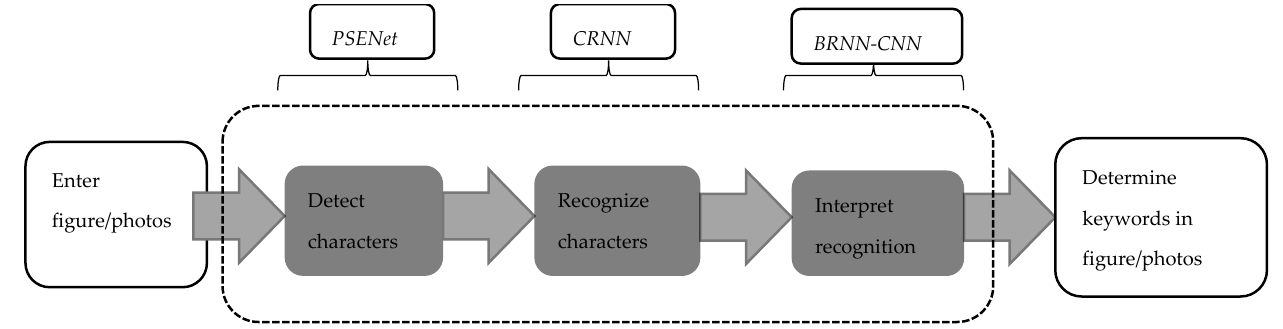
Figure 2. Mechanism for Contract Keyword Detection (CKD) approach .